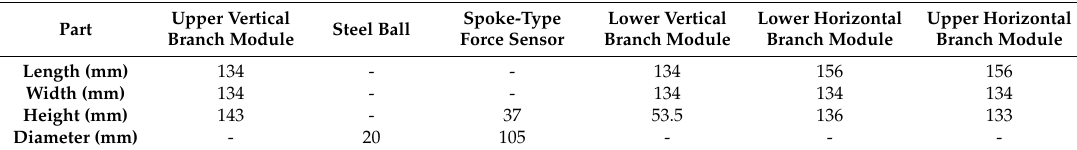
Table 2. The specifications of the major parts of the sensor. Upper Vertical Steel Ball Branch Module